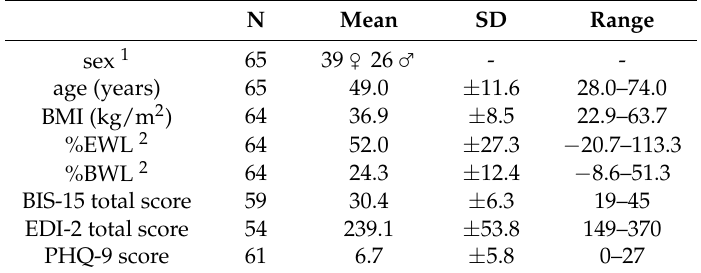
Table 1. Characteristics of patients four years after laparascopic sleeve